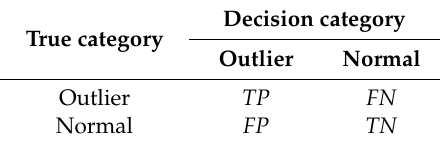
Table 2. Confusion matrix of classification